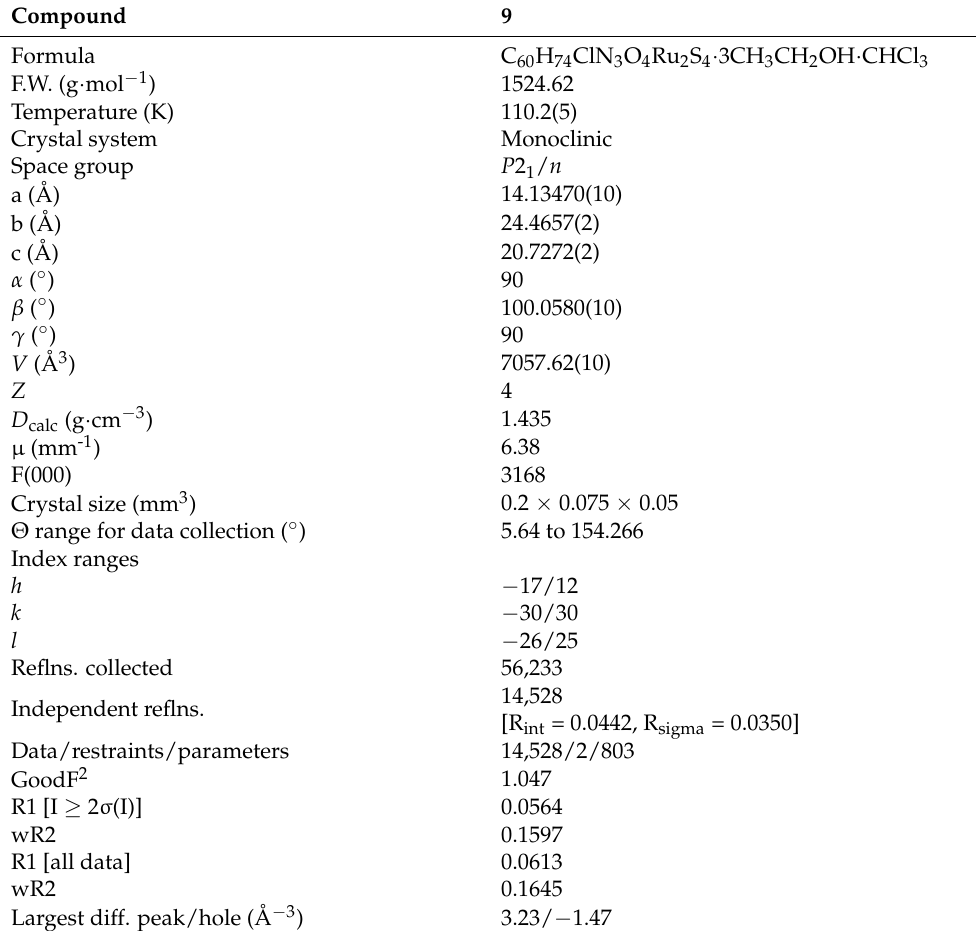
Table 1. Crystal data and structure refinement for 9 .